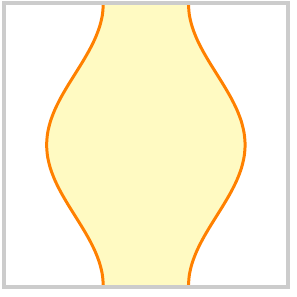
FIG. 1. A Fermi liquid with a Fermi surface that wraps nontrivially around the Brillouin torus does not exhibit quantum